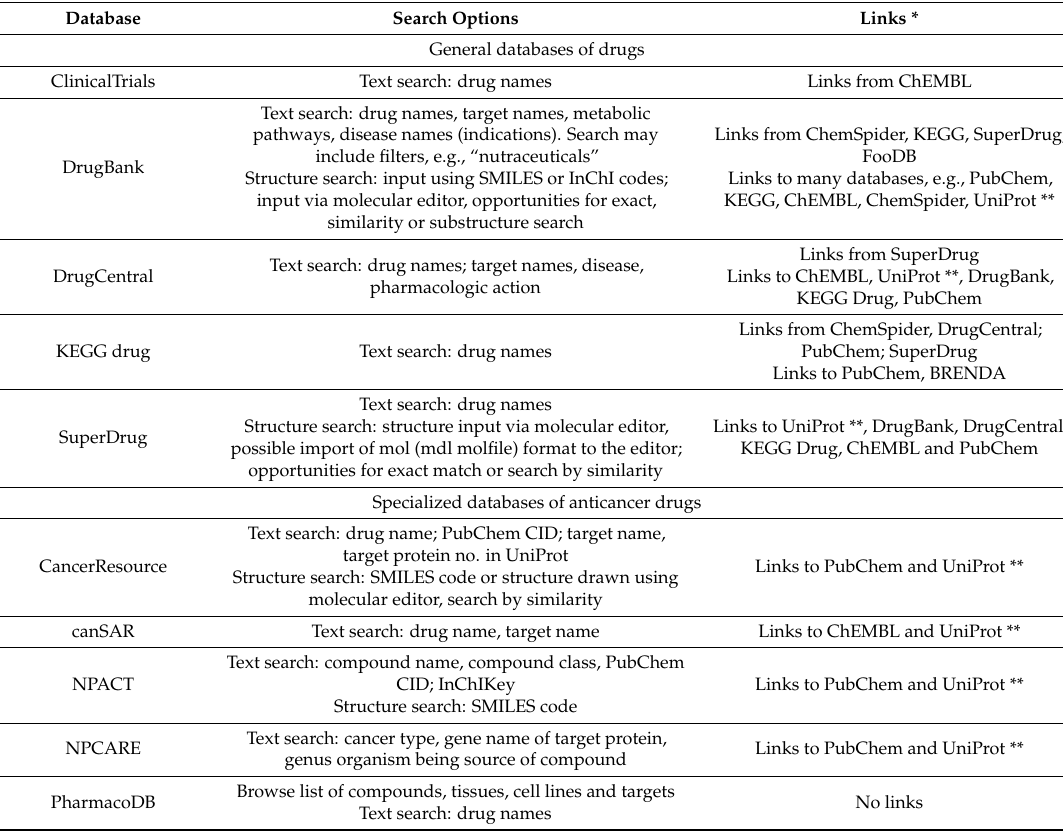
Table 2. Search options and links between databases containing information about anticancer